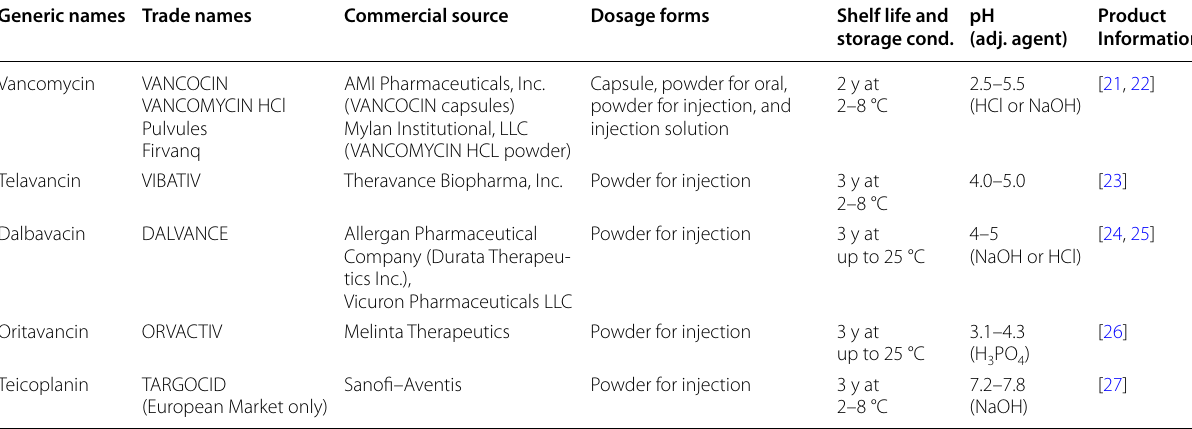
Table 1 Therapeutic glycopeptide-based products in the